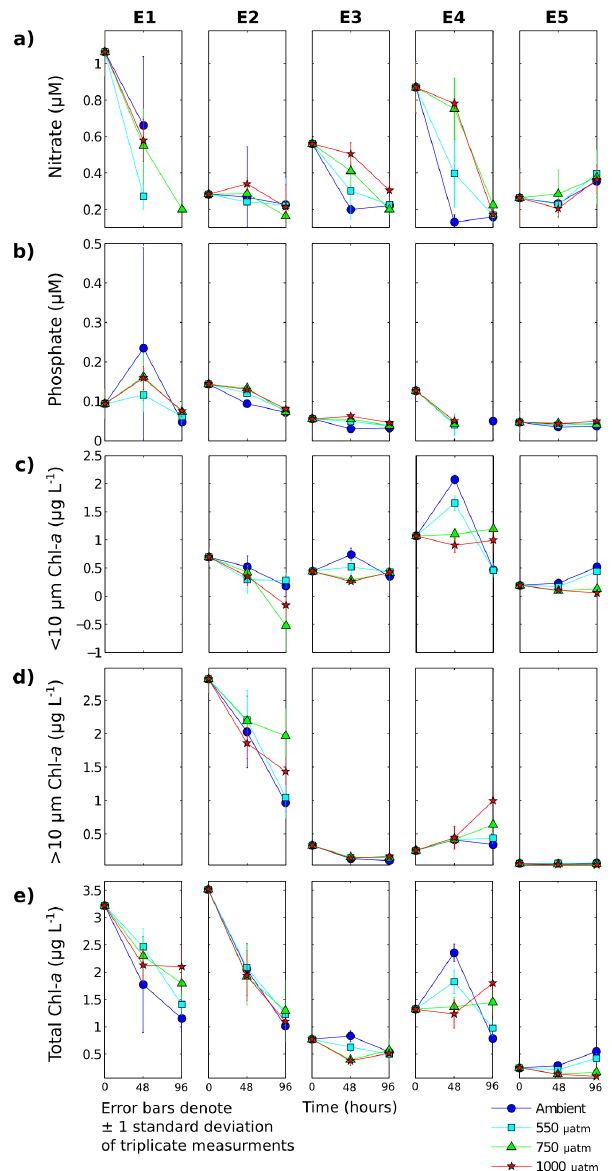
Figure 3. Evolution of environmental variables in five bioassay ex- periments across three time points for all p CO 2 treatments: (a) ni- trate (µM), (b) phosphate (µM), (c) small size fraction ( < 10µM) chlorophyll a ( µ gL − 1 ), (d) large size fraction ( > 10µM) chloro- phyll a (µgL − 1 ) and (e) total concentration of chlorophyll a (µgL − 1 ). Legend shows the colours and symbols used to denote the different p CO 2